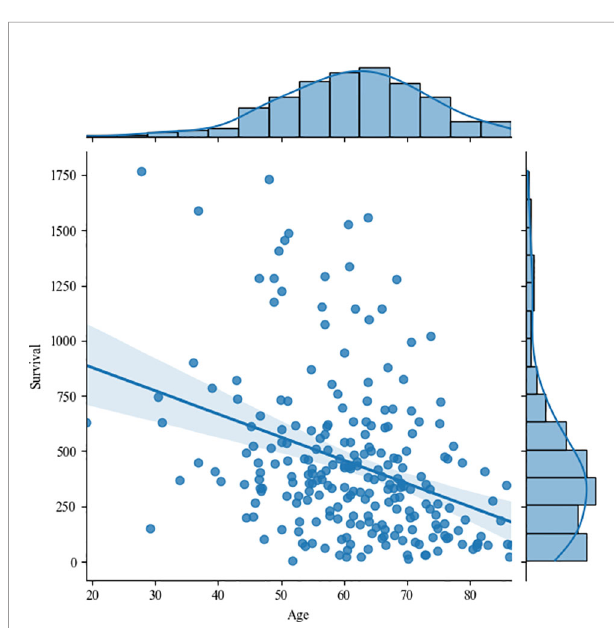
FIGURE 16 | The correlation between age and survival